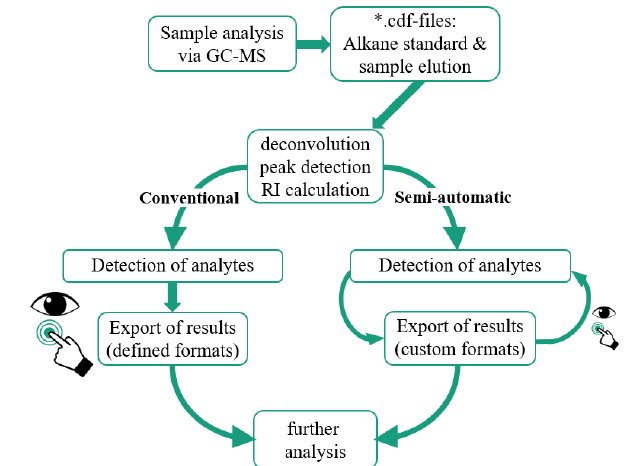
Figure 1. Process of sample analysis in conventional and in our pro- posed semi-automated analysis. Eye and hand icons indicate data inspection and interaction, with their size relative to the necessary amounts of these